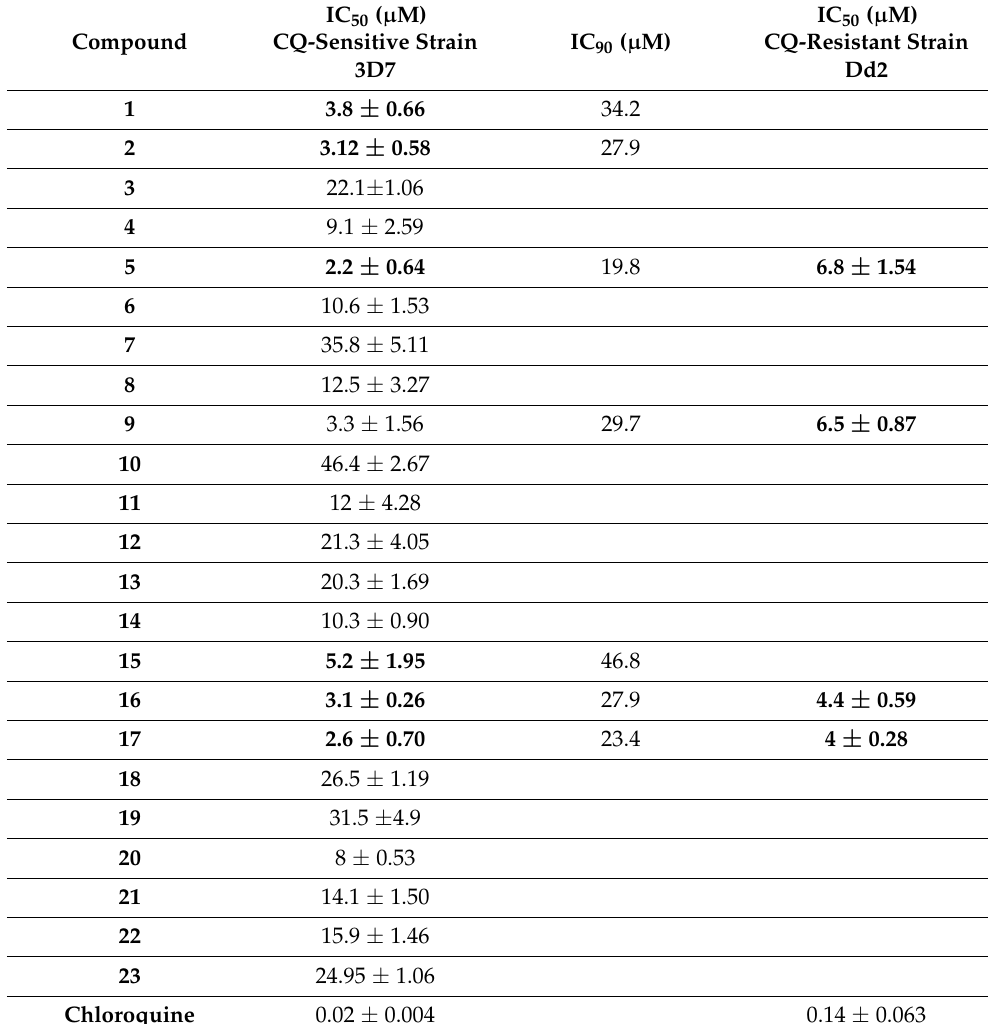
Table 1. Antiplasmodial effect of compounds against the CQ-sensitive 3D7 and CQ-resistant Dd2 strains of P. falciparum